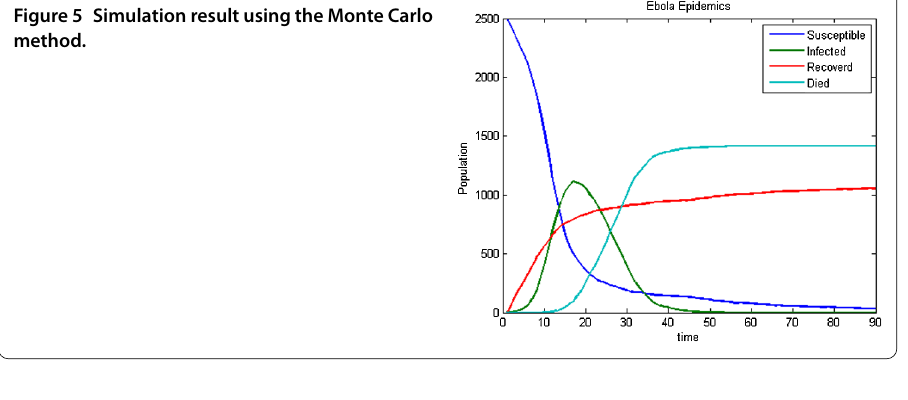
Figure 6 Effect of the rate of infected quarantine on infected